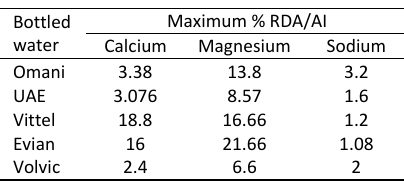
Table 6: Comparison of maximum % DRI of calcium, magnesium and sodium in Omani and UAE brands Maximum % RDA/AI Bottled water Calcium Magnesium Omani